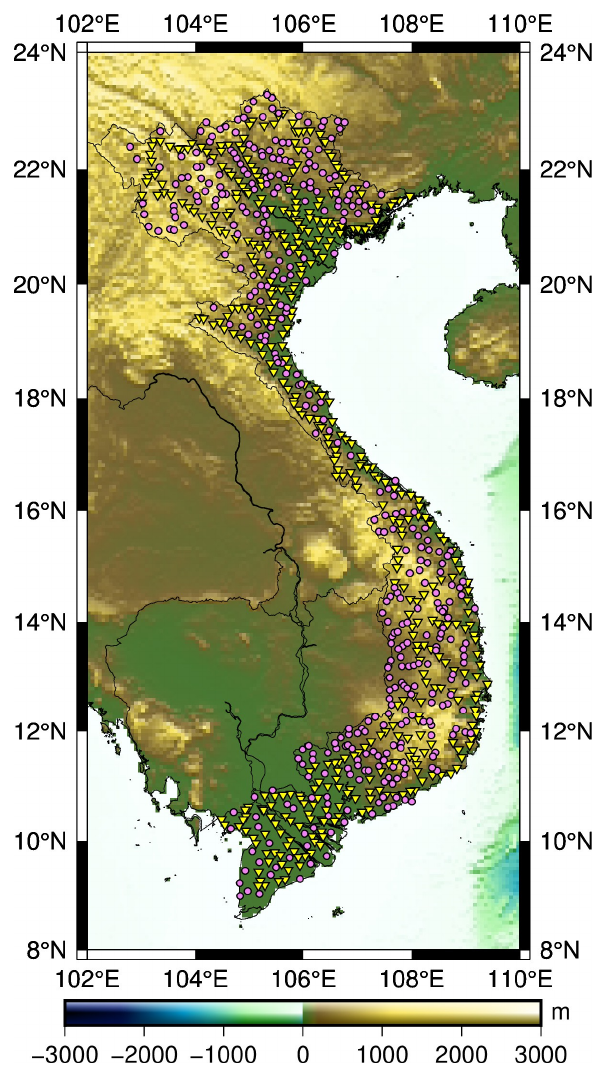
Figure 2. Global Navigation Satellite System (GNSS)/levelling data: yellow dots are first- and second-order levelling benchmarks, whereas purple dots denote third-order ones.